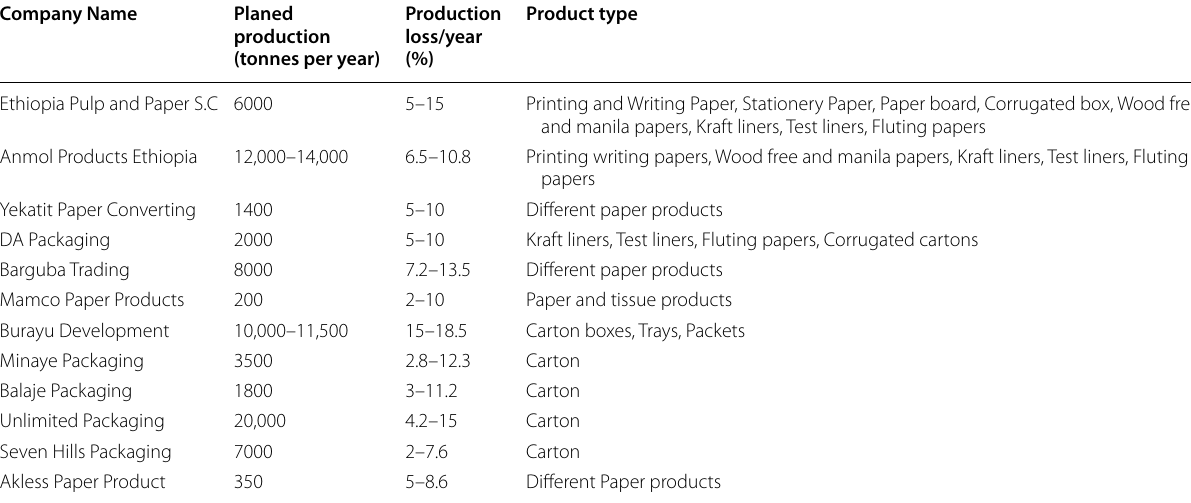
Table 2 Status of paper manufacturing in Ethiopia Company